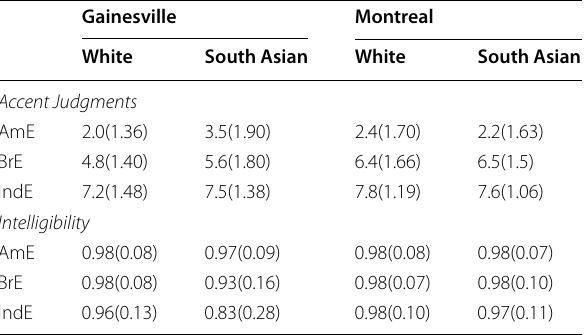
Table 2 Summaries of the Mean and Standard Deviation (in parenthesis) of the accentedness judgments and